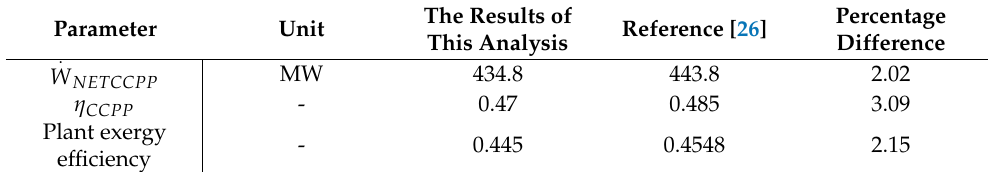
Table 5. Validation results for CCPP.